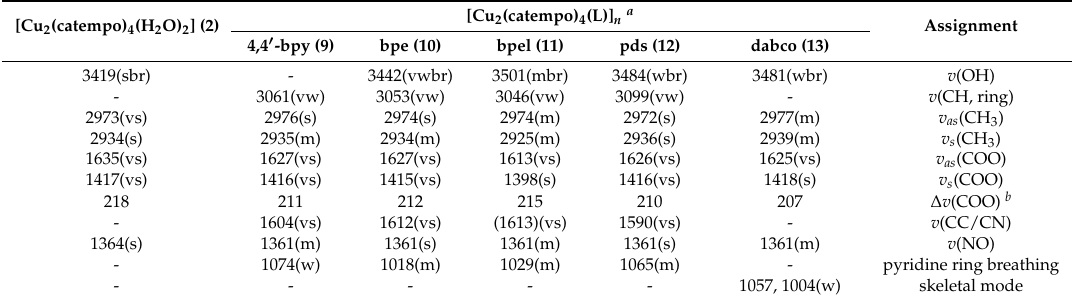
Table 2. Infrared spectral data of [Cu 2 (catempe) 4 (H 2 O) 2 ] ( 2 ) and chain compounds [Cu 2 (catempo) 4 (L)] n L = 4,4 (cid:48) -bpy ( 9 ), bpe ( 10 ), bpel ( 11 ), pds ( 12 ), and dabco ( 13